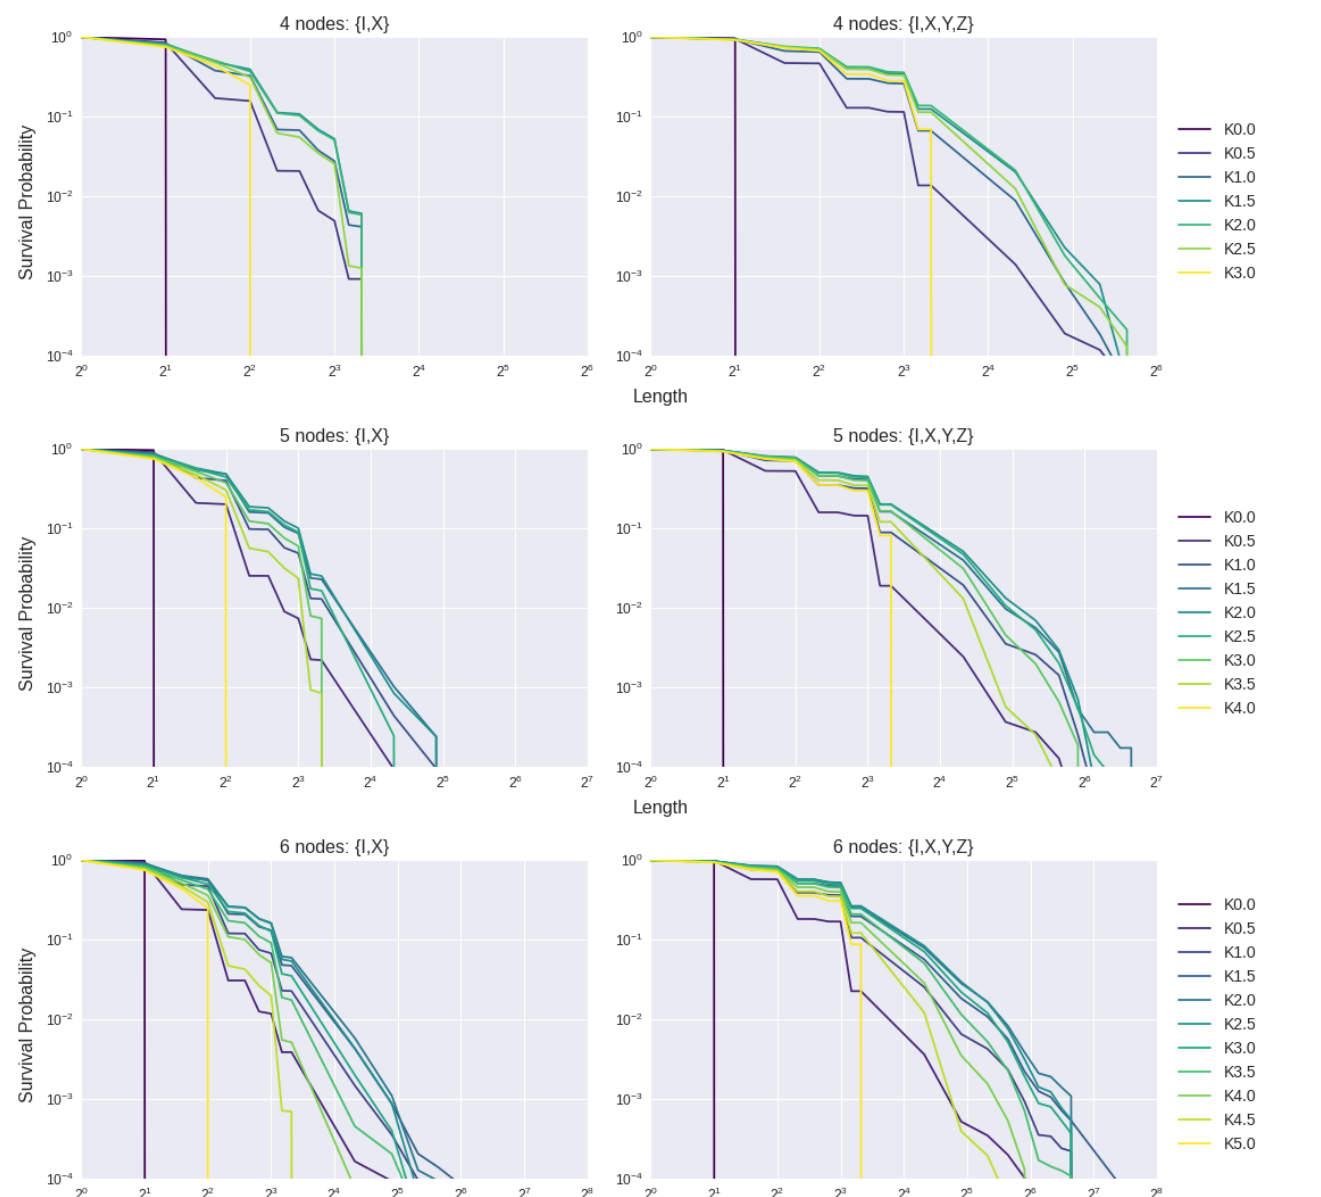
Figure A1. Survival probability for different connectivity values of QBNs with 3, 4, 5, and 6 nodes. The survival prob- ability was computed from 20,000 realizations. For practical reasons (extremely large cycles and computational errors), configurations that can produce superpositions were